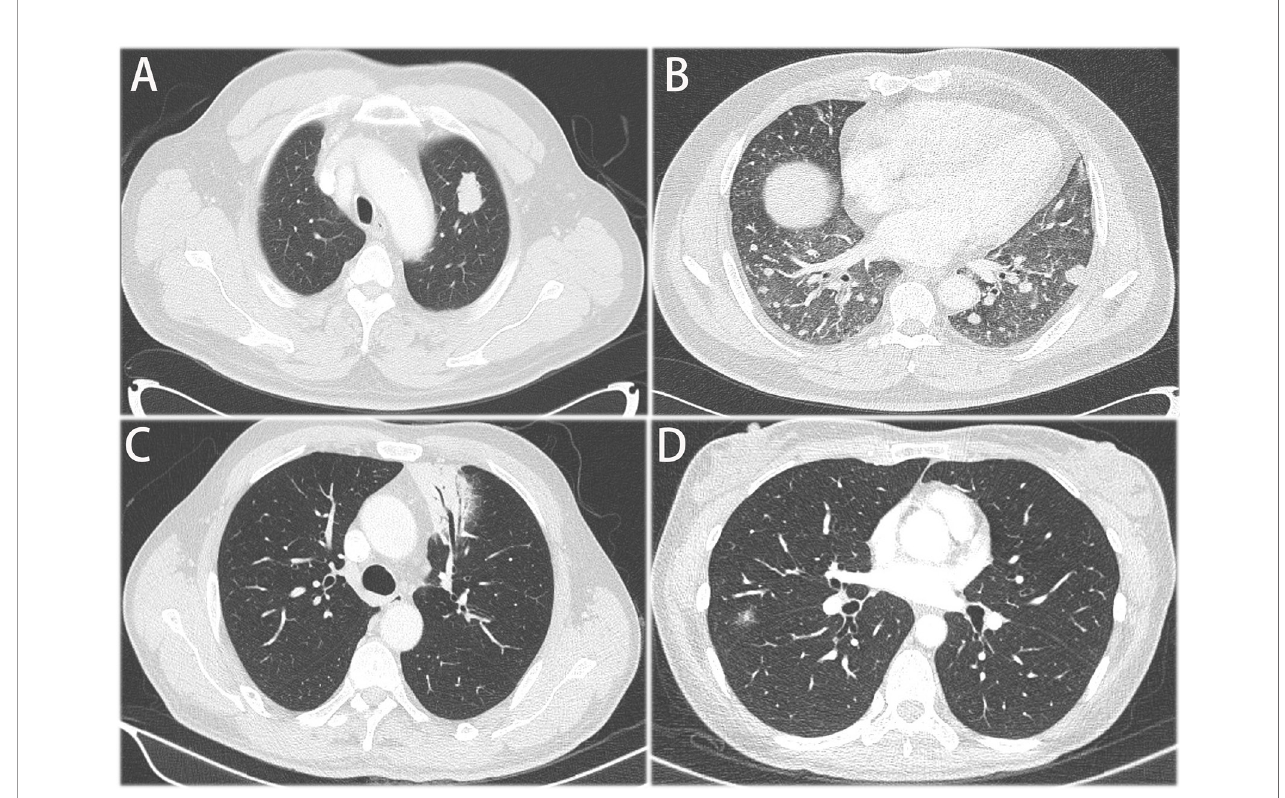
FIGURE 1 | Representative CT images of primary pulmonary. (A) solid nodule or mass, (B) multiple nodules or masses (C) pneumonia-like consolidative pattern, (D) ground glass